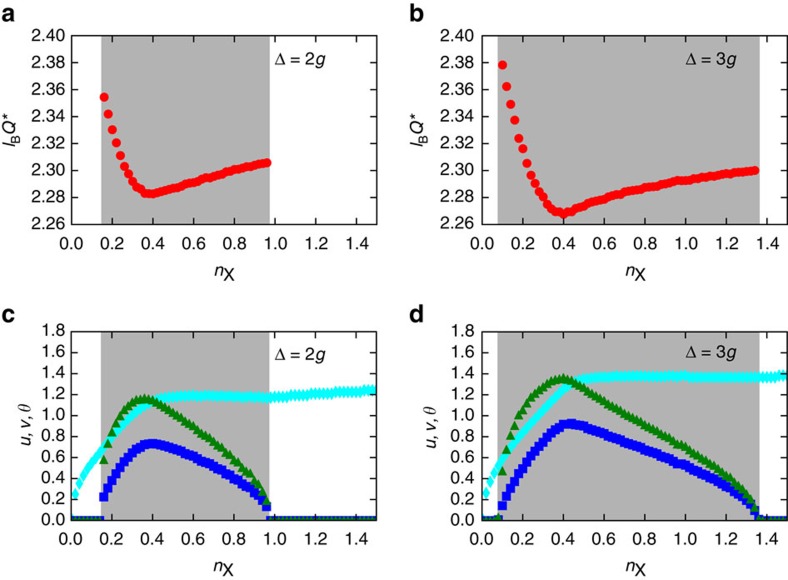
Variational parameters of the modulated phase.This figure shows the optimal values of the variational parameters u,v,θ and Q* in equation (30) for a cavity dielectric constant κr=5, highest occupied LL M=1 and different values of the detuning Δ. (a,c) Δ=2g. (b,d) Δ=3g. (a,b) Dependence of the characteristic wave number Q* (in units of ) on the density nX of total excitations. (c,d) Dependence of the quantities u (blue squares), v (green triangles) and θ (cyan diamonds) on the density nX of total excitations. Grey-shaded areas have the same meaning as in Fig. 2.